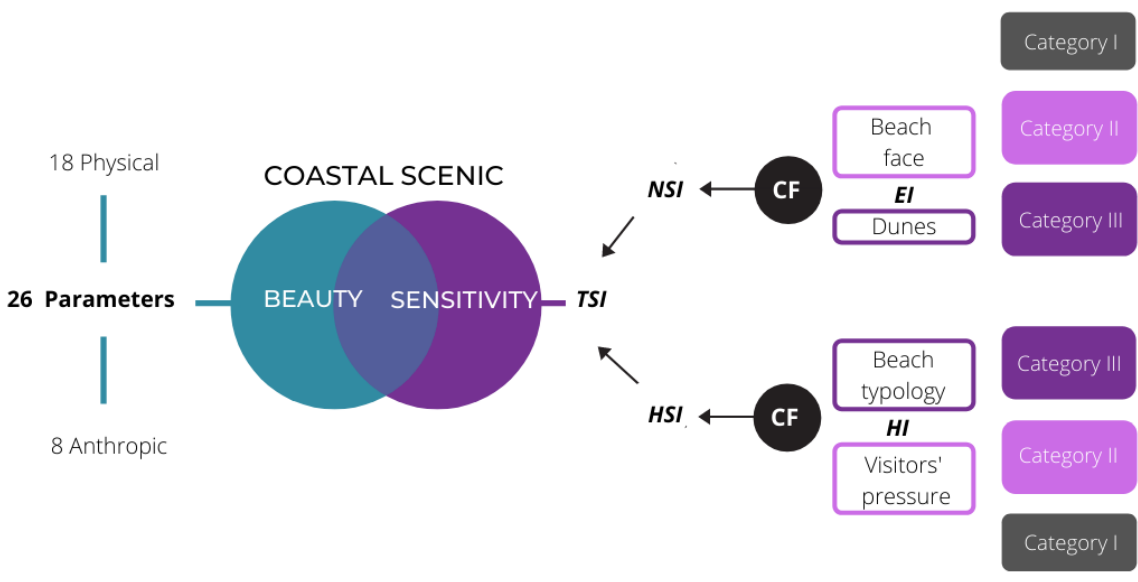
Figure 2. Overview of methods and parameters used for CSES and CSSI.